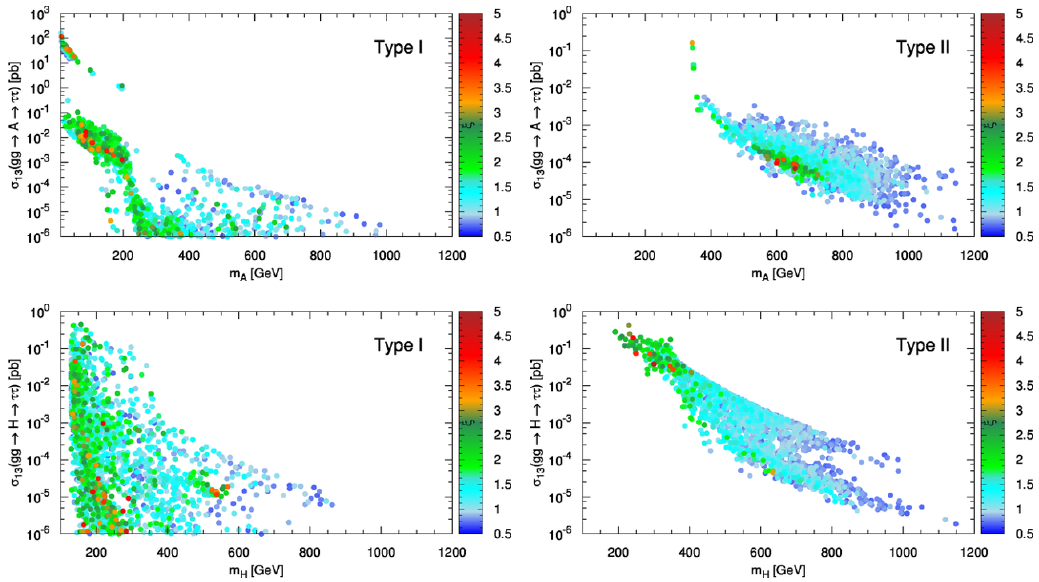
Figure 16 . 13 TeV cross-sections at the LHC as a function of the relevant mass scale, for the gg ! A ! (cid:28)(cid:28) (upper panels) and gg ! H ! (cid:28)(cid:28) (bottom panels) channels in Type I (left panels) and Type II (right